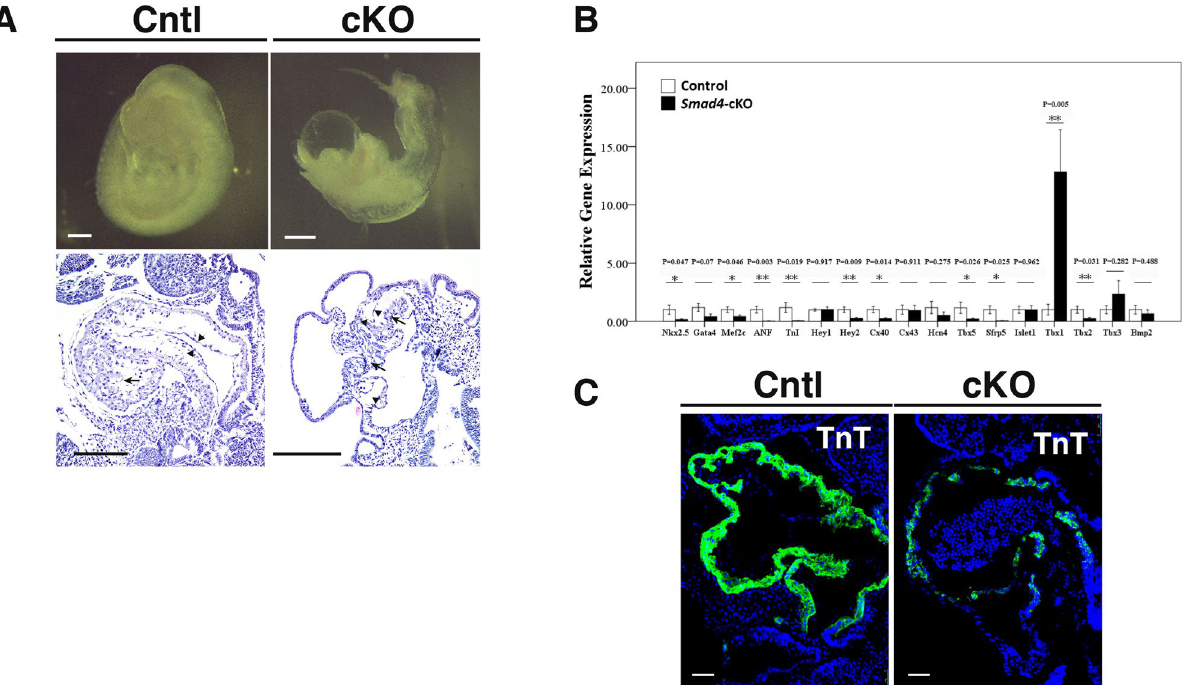
Figure 1. Disruption of the Smad4 gene in Sfrp5 -expressing cells leads to hypoplastic heart formation and impaired cardiac differentiation. ( A , B ) Gross appearance ( A ) and Hematoxylin and Eosin staining ( B ) of sagittal sections of Smad4 mutant ( Sfrp5 Cre/ + ; Smad4 del/del ) and littermate control ( Sfrp5 Cre/ + ; Smad4 del/ + ) embryos dissected at E9.5. Scale bar = 100 μm. ( C ) Relative gene expression levels of key factors involved in cardiogenesis. n = 9 and 7 for control and Smad4 -cKO, respectively. Data are presented as mean ± SEM. ( D ) Immunofluorescent staining for cTnT (green) in control and Smad4 mutant embryos at E9.5. Samples were counterstained with 4 ′ , 6-diamidino-2-phenylindole (DAPI) to visualize nuclei (blue). Scale bar = 50